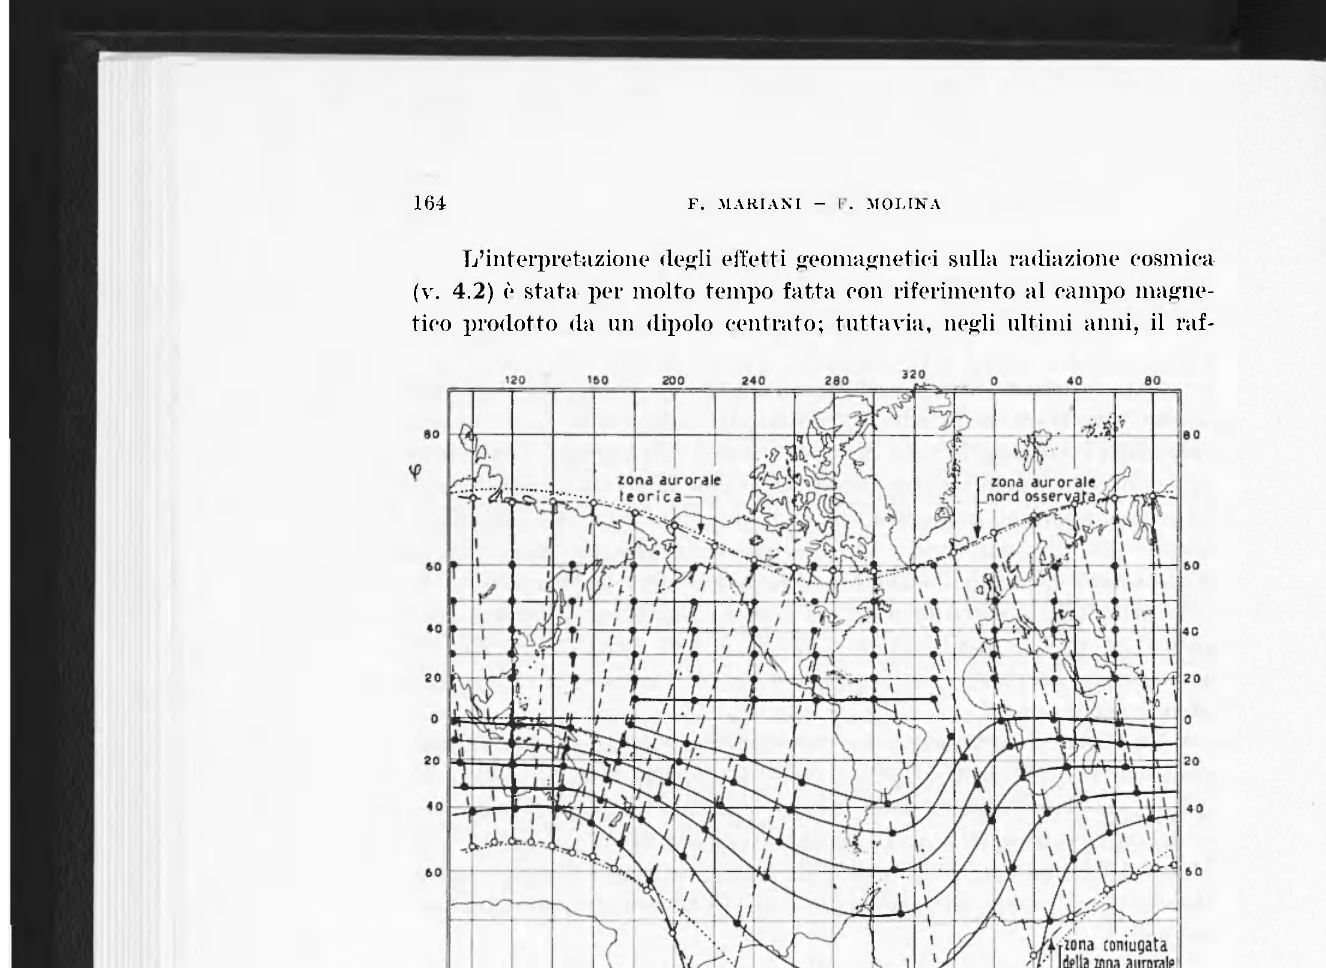
Fig. 5.1 Rappresentazione dei punti magneticamente coniugati, interse- zione delle linee di forza del campo magnetico terrestre con la superfìcie della Terra; tp e A, latitudine e longitudine geografiche (secondo Vestine e